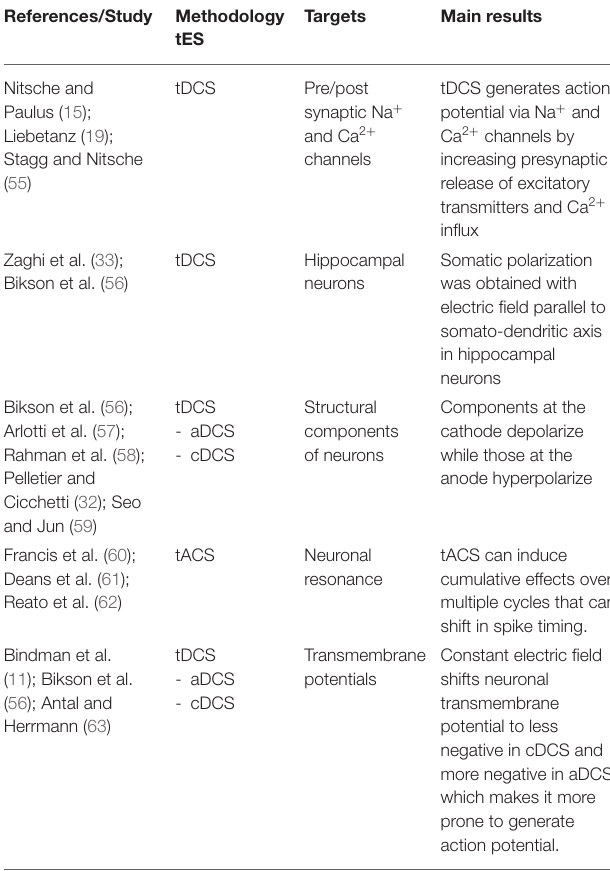
TABLE 1 | tES after-effects on membrane